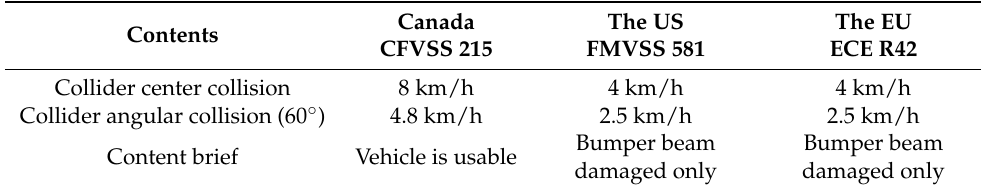
Table 6. Bumper beam regulations in various